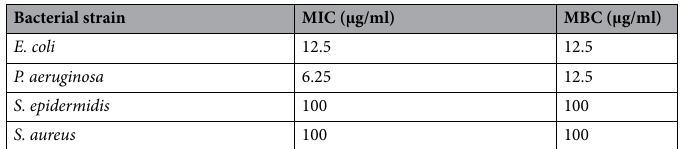
Table 2. Minimum inhibitory concentration (MIC) and minimum bactericidal concentration (MBC) of AgNPs against E. coli , P. aeruginosa , S. epidermis and S. aureus .